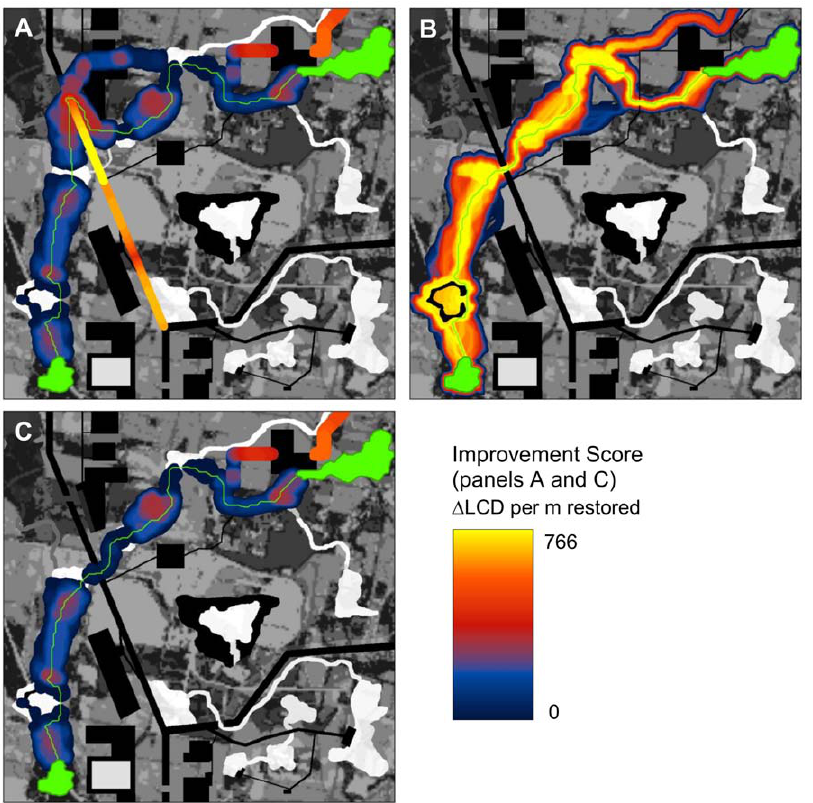
Figure 3. Barrier analysis of landscape. (A) Improvement scores ( D LCD ) for a 60 m search diameter using an enhanced version of Linkage Mapper software ([40]). Only positive values (indicating barriers whose removal would reduce isolation) are shown. To facilitate visualization of the barriers, scores were mapped so that they filled the search window (i.e. the maximum D LCD value within the search radius of each pixel is displayed). The greatest improvement potential was detected crossing the highway. Note that a natural corridor is bisected by the highway at the point with the highest improvement potential (see detail in Figure 2). (B) Creating a new gap in the barrier where restoration potential is highest re-routes the modeled least-cost corridor and greatly reduces resistance between the patches ( LCD =78,503 weighted meters compared with an LCD of 124,443 pre-restoration). Best 20% of study area shown. (C) Barrier detection at 60 m search diameter after restoration.